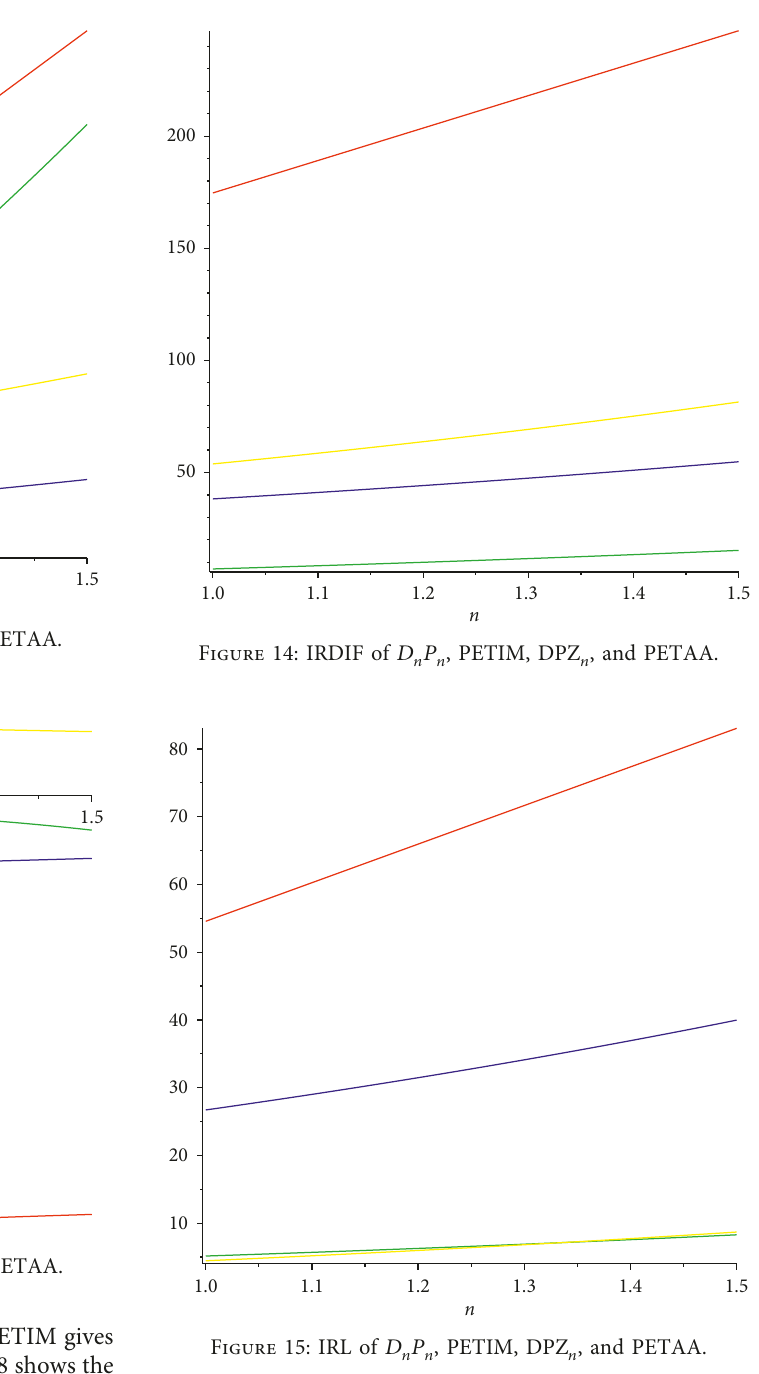
P n n , PETIM, DPZ n , and